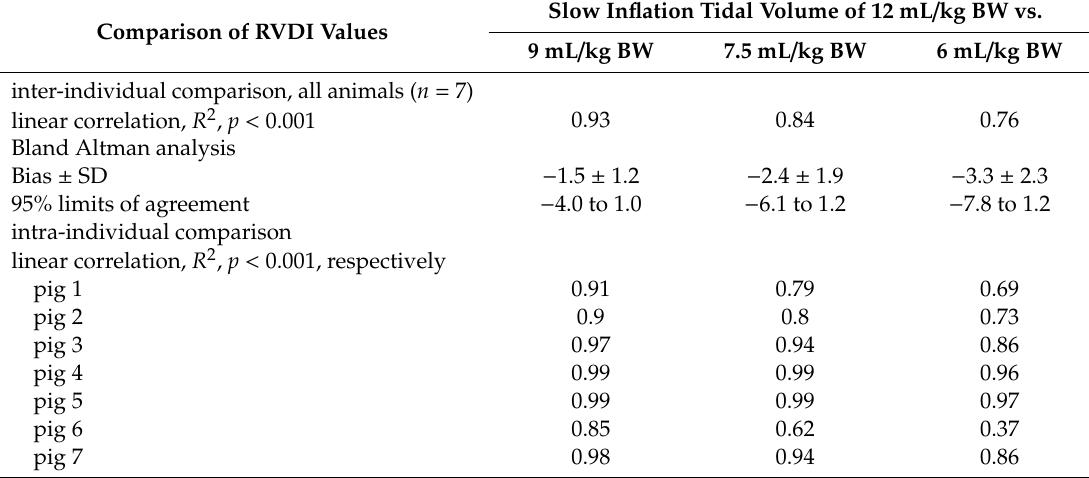
Table 1. Comparison of RVDI values obtained from di ff erent slow inflation V T maneuvers using Electrical Impedance Tomography.